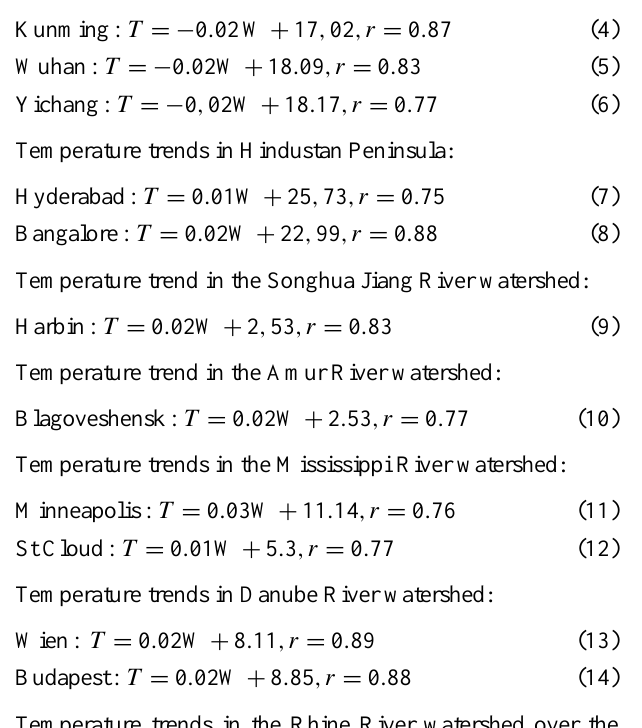
activity over a period of many years. Where Q – river discharge in